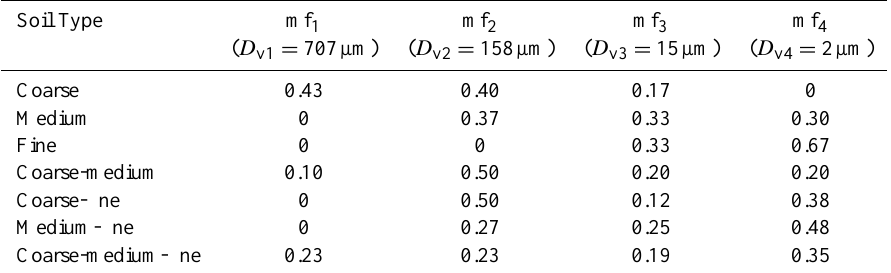
Table 3. Zobler soil texture classification and mass fraction for each soil size population after Tegen et al. (2002). For all particle sizes the geometric standard deviation σ g is